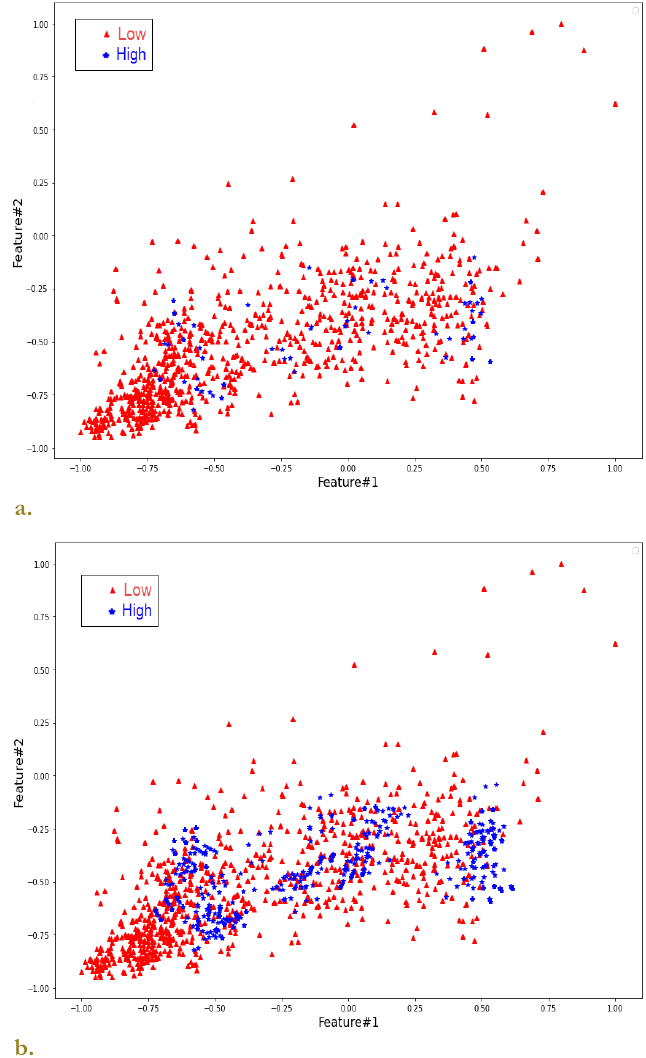
Fig. 9. SMOTE effect on the Neuroticism trait in the UTS dataset; a. original data, b. data balancing with